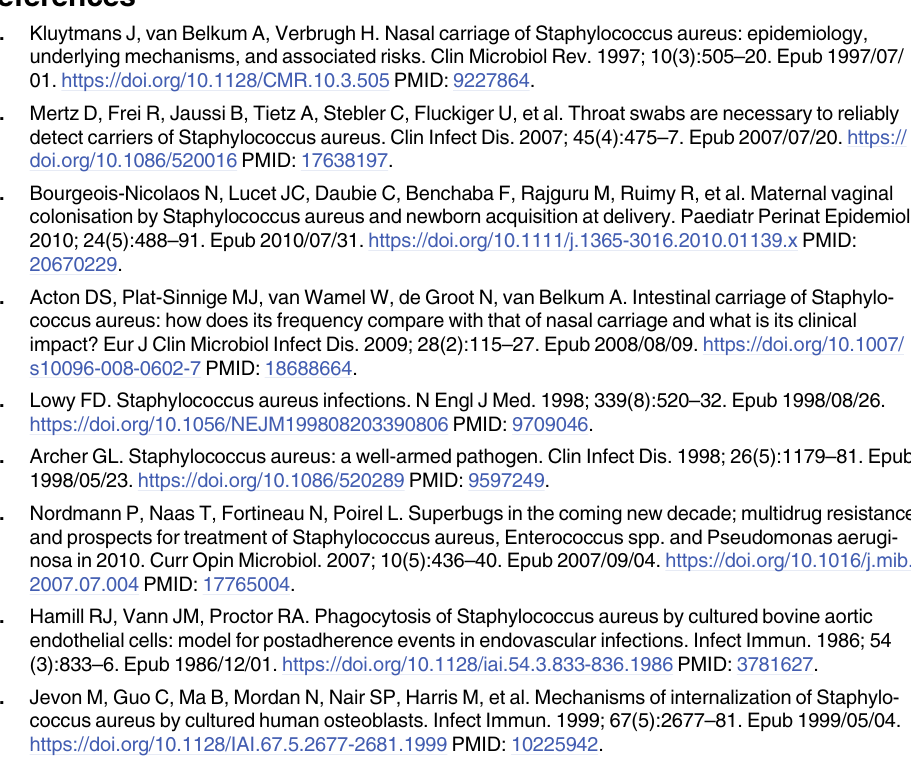
S3 Table. Oligonucleotides used in this study.